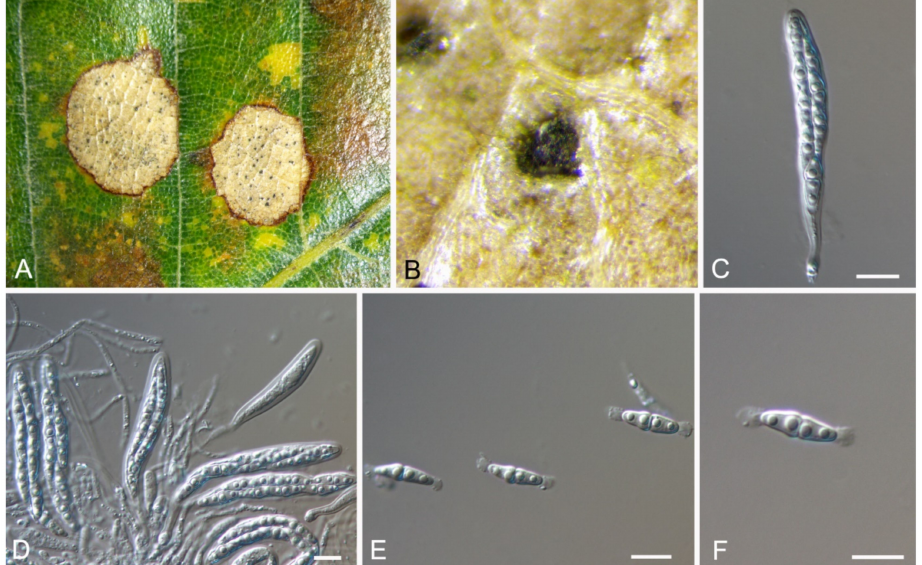
Figure 3. Phyllosticta capitalensis (BJFC-S1821). ( A , B ) Ascostromata on the diseased leaves of Castanea mollissima ; ( C , D ) Asci; ( E , F ) Ascospores. Scale bars: ( C – F ) = 10 µ m.